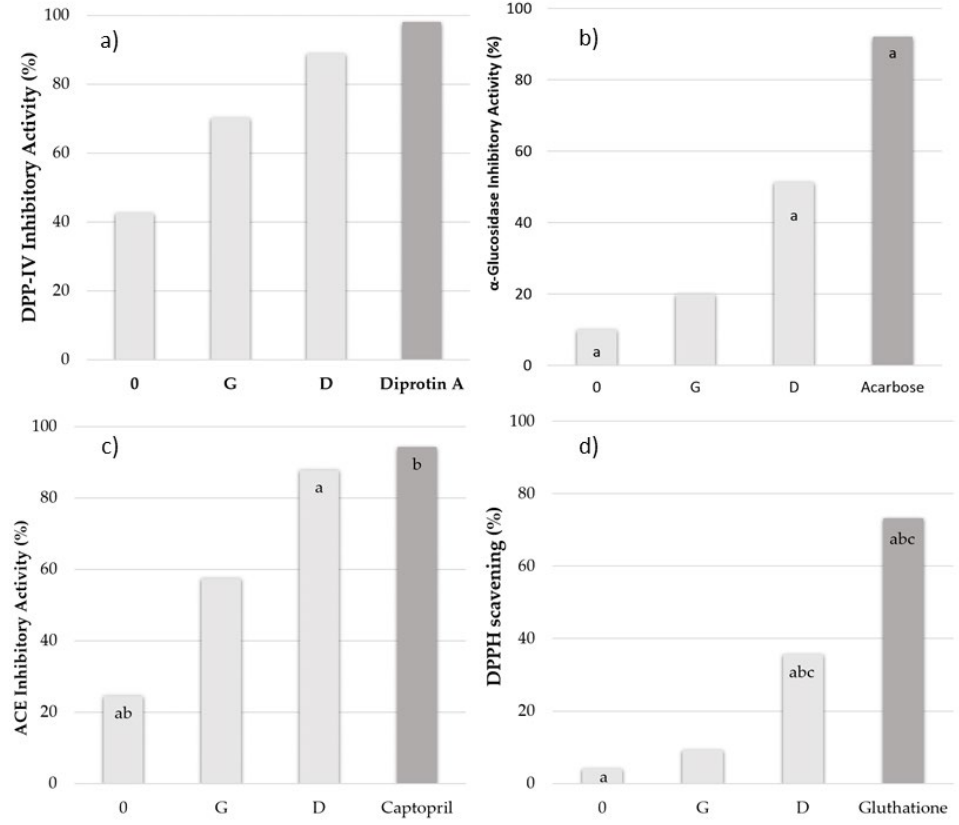
Figure 2. Bioactivity of digested oat kernel proteins expressed as % of inhibitory activity: ( a ) DPP-IV inhibitory, ( b ) α -glucosidase inhibitory, ( c ) ACE inhibitory and ( d ) antioxidant activities; where 0—intact sample, G—sample after 2 h gastric phase, D—sample after 2 h duodenal phase